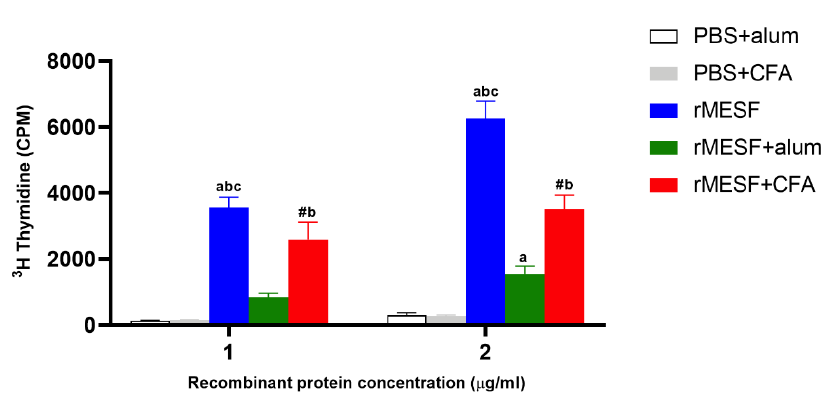
Figure 6. Lymphocyte proliferation. Splenocytes were collected from mice groups (n = 5 mice/group) after 30 days of the last immunization and stimulated in vitro with 1 μg/mL or 2 μg/mL with rMESF multiepitope fusion protein. Symbols and letters indicate statistically significant values of p < 0.0001 compared with the respective mice group. # vs. PBS+CFA, a vs. PBS+alum, b vs. rMESF + alum, c vs. rMESF + CFA. PBS, phosphate-buffered saline. CFA, complete Freund’s adjuvant. Results are plotted as mean ± standard deviation.